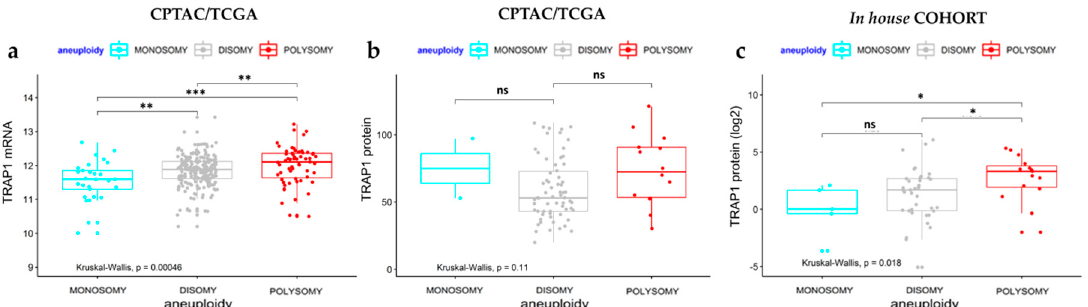
Figure 2. Correlation between TRAP1 mRNA and protein expression and its copy number variation. ( a , b ) Distribution of TRAP1 mRNA ( a ) and protein ( b ) expression according to its copy number variation in the National Cancer Institute’s Clinical Proteomic Tumor Analysis Consortium / The Cancer Genome Atlas (CPTAC / TCGA) colorectal carcinoma database. ( c ) Distribution of TRAP1 protein expression according to its copy number variation in our cohort of human colorectal carcinomas. a. 299 cases b. 81 cases, c. 58 cases. TRAP1 mRNA and protein expression are reported as absolute values in CPTAC / TCGA samples analyzed by RNAseq and mass spectroscopy technologies ( a , b ) and as fold change increase respect to non-infiltrated normal mucosa in our in-house cohort analyzed by immunoblot ( c ). p -values: * p < 0.05, ** p < 0.01, *** p < 0.001. n.s.: Not significant.